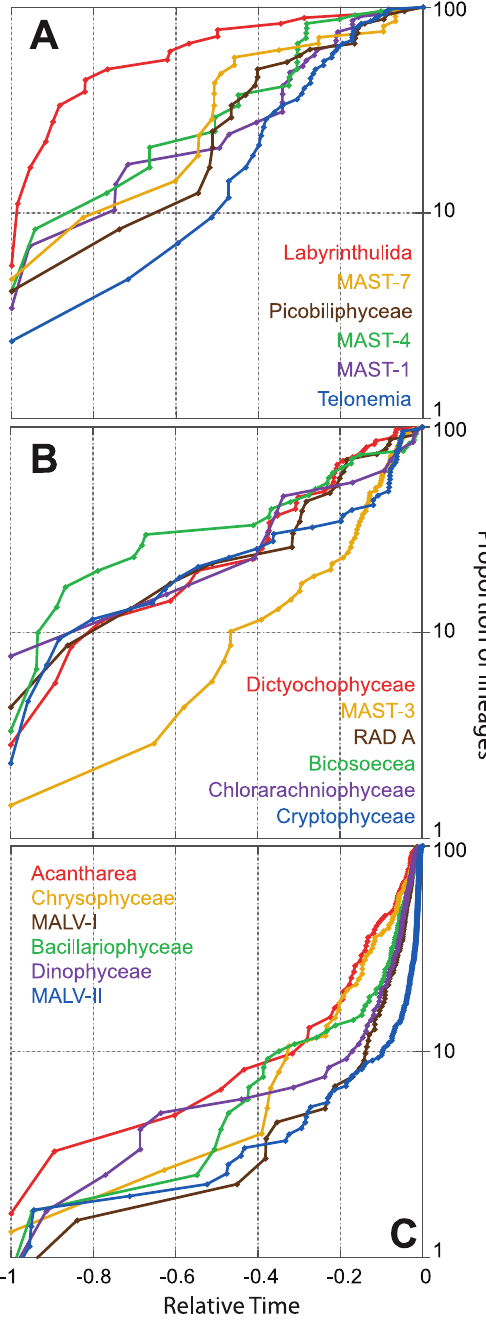
Figure 5. Phylogenetic structure of several groups of marine protists. Lineage Through Time (LTT) plots are based on the trees shown in Figure 2–3 and are displayed for groups having c , 0 (A), c =0 (B) and c . 0 (C), which indicates early, constant or late cladogenesis events, respectively. The number of lineages is standardized to the maximum number at present and relative time is